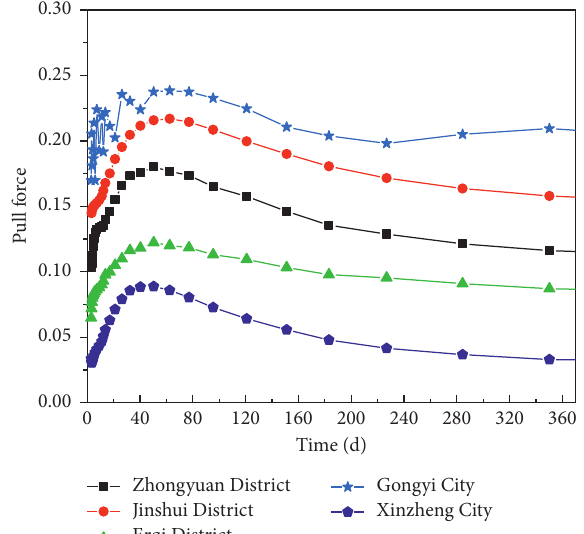
Figure 6: Relationship between pull force and time among urban areas.